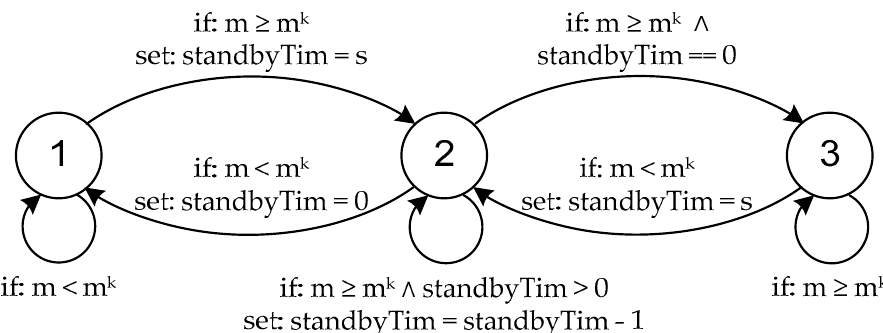
Figure 2. State machine presenting the transitions between individual states of nodes. Based on the adopted model, an algorithm for simulating the operation of the sensor network was developed, the diagram of which is presented in Listening 1. Listening 1. Sensor network simulation algorithm.